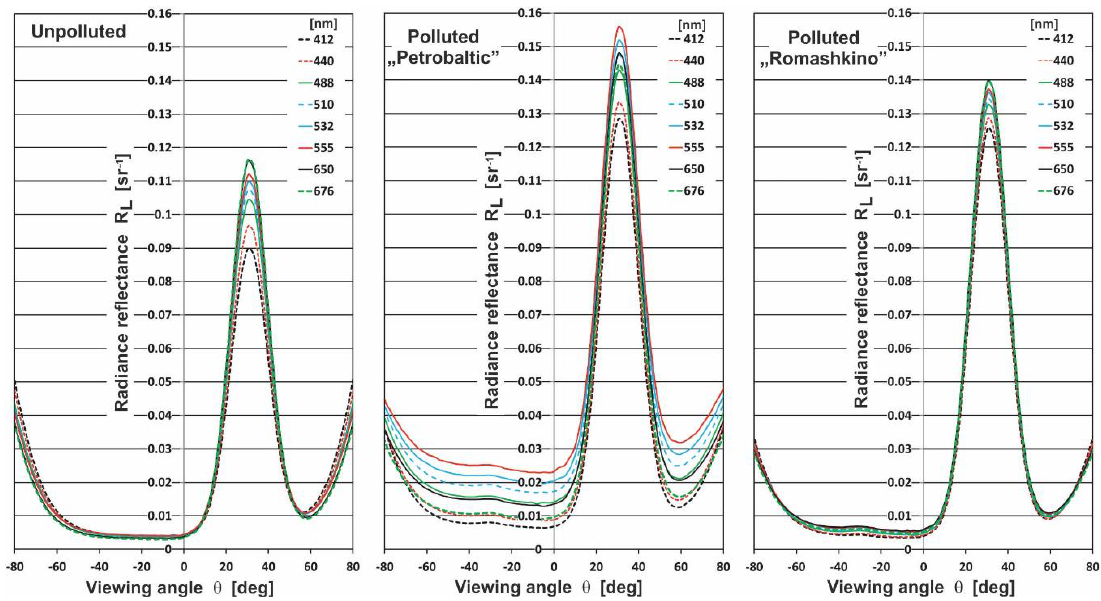
Figure 2. The radiance reflectance R L above sea surface as a function of viewing angle θ for selected wavelengths, 412 nm, 440 nm, 488 nm, 510 nm, 532 nm, 555 nm, 650 nm, and 576 nm, respectively, and θ changes in the range from −80° to 80° for natural seawater (unpolluted) and seawater polluted by Petrobaltic and Romashkino oil for 10 ppm oil concentration.